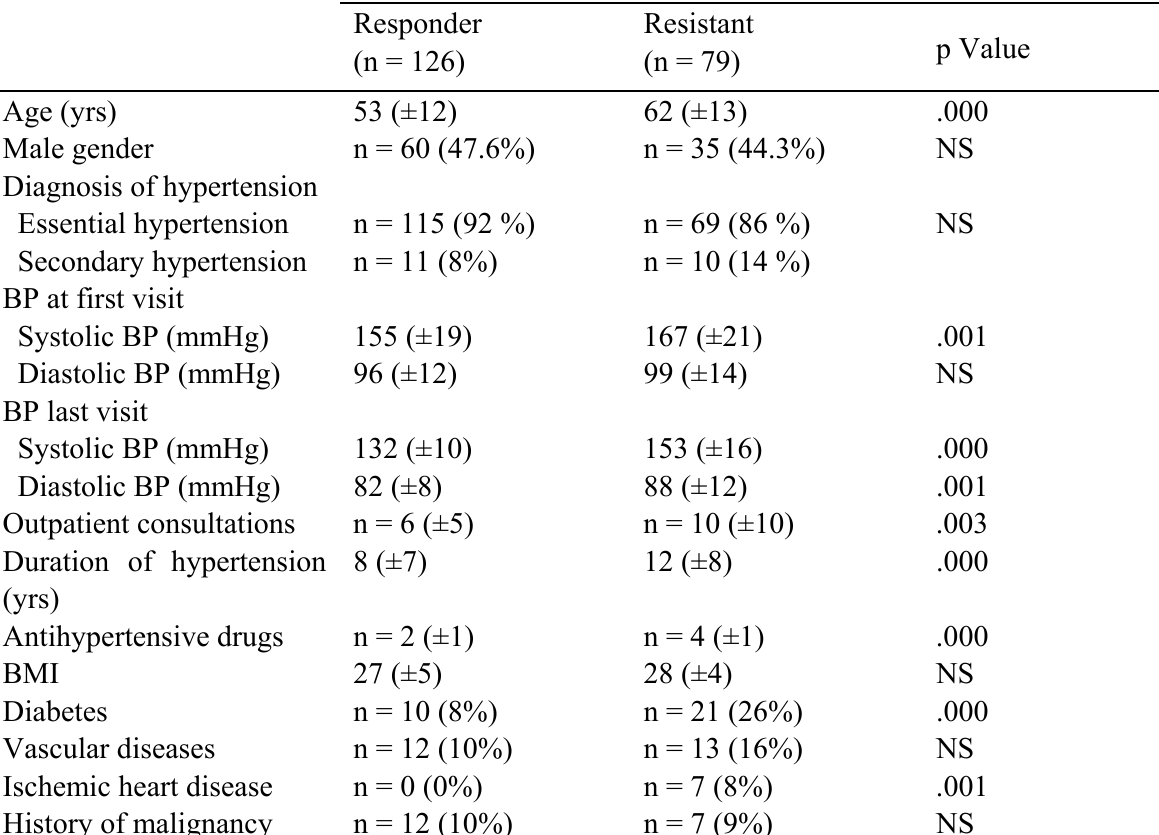
Table 1. Demographic and clinical characteristics of “responder” and “resistant”